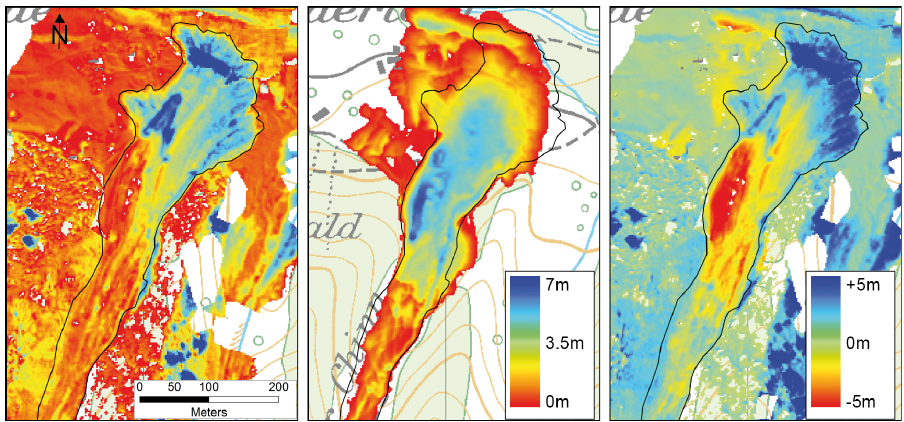
Fig. 16. Deposit ] 2. Comparison between the measured snow depth, h s (left) and the deposit depths obtained from simulation ] 1 (center). The right panel shows differences between the measured and simulated depths. The simulation overestimates the deposition depths at the dam.